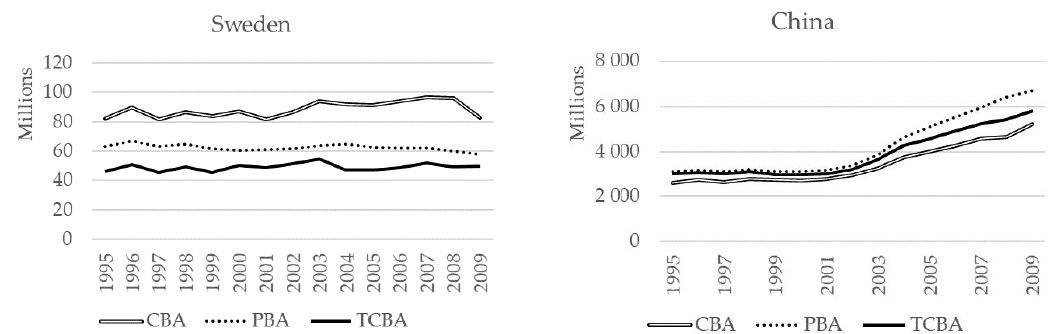
Figure 1. Technology-adjusted CO 2 footprints (TCBA) of Sweden and China compared to national territorial emissions (or production-based account: PBA) and national carbon footprints (or consumption- based accounts: CBA). Note: million tons CO 2 emissions.